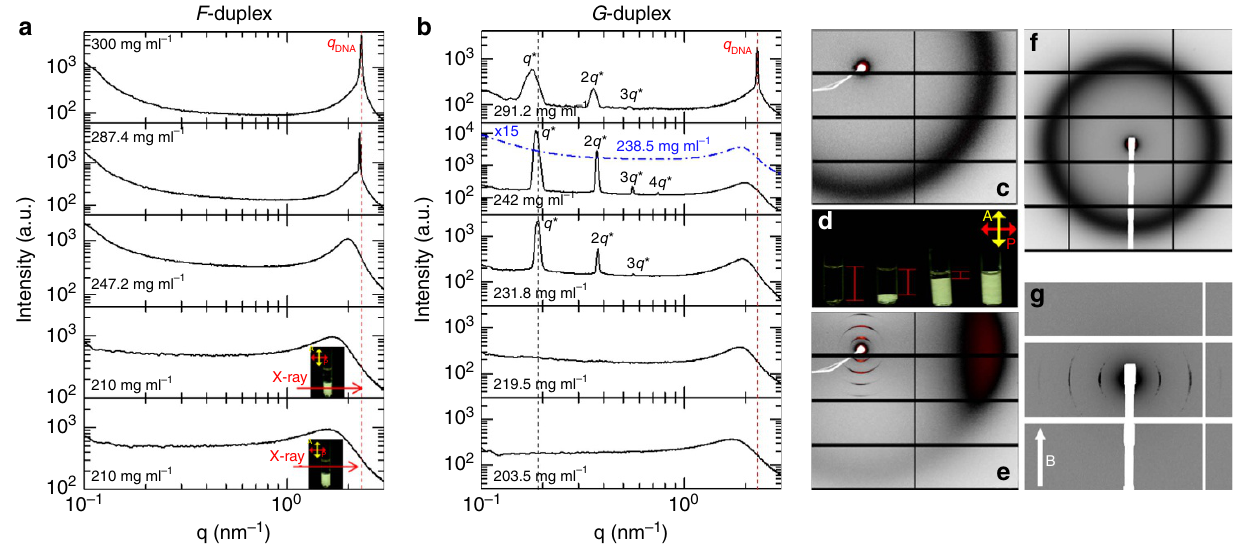
Figure 2 | Sm-A ordering in a suspension of gapped DNA duplexes. ( a ) X-ray scattering patterns for the F-duplex, with concentrations from top to the bottom are 300.0, 287.4, 247.2 and 210mgml (cid:2) 1 (for the two lower patterns). The insets for the two lower concentrations show the location of the X-ray beam (the red arrows) through the bottom birefringent phase and the upper non-birefringent phase, respectively. The two bottom 1D-SAXS profiles are measured using an in-house SAXS setup. ( b ) X-ray scattering patterns for the G 20T -duplex, with concentrations from top to the bottom 291.2, 242.0, 231.8, 219.5mgml (cid:2) 1 (taken from the LC region of the third capillary from the left in the photograph in d ), and 203.5mgml (cid:2) 1 (taken from the isotropic region of the second capillary from the left in the photograph of d ). The correlation peaks assigned as q * together with their higher-order reflections at 2 q *, 3 q *, 4 q * correspond to a lamellar morphology. The blue-dashed curve in the second upper scattering pattern is for the G 1T -duplex at a concentration of 238.5mgml (cid:2) 1 (the intensity is shifted by a factor of 15 for clarity). The top and the two bottom 1D-SAXS profiles are measured using an in-house SAXS setup. ( c ) 2D-SAXS scattering pattern for the F-duplex at 247mgml (cid:2) 1 . ( d ) G 20T -duplex samples in two-phase coexistence observed between cross-polarizers (total concentrations from left to right: 195.3, 203.5, 219.5 and 231.8mgml (cid:2) 1 ). The red bars indicate the height of the isotropic region. ( e ) 2D-SAXS pattern for a shear-aligned sample of the G 20T -duplex at 242.0mgml (cid:2) 1 , ( f ) for the G 1T -duplex at 238.5mgml (cid:2) 1 and ( g ) for a magnetically aligned sample of the G 20T -duplex at 255.0mgml (cid:2) 1 . The 2D-SAXS images presented in ( c , e – g ) are taken with a Pilatus 1 and 2M detector, respectively; the red colour corresponding to the highest intensity. The red and black dotted lines are a guide for the concentration dependence of the q DNA and q * peaks,